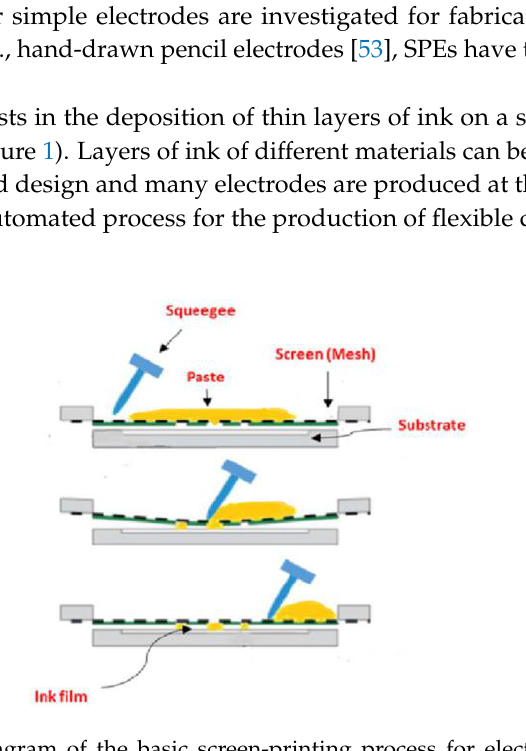
Figure 1. Schematic diagram of the basic screen-printing process for electrodes manufacturing. Reprinted from [54], with permission from Elsevier.